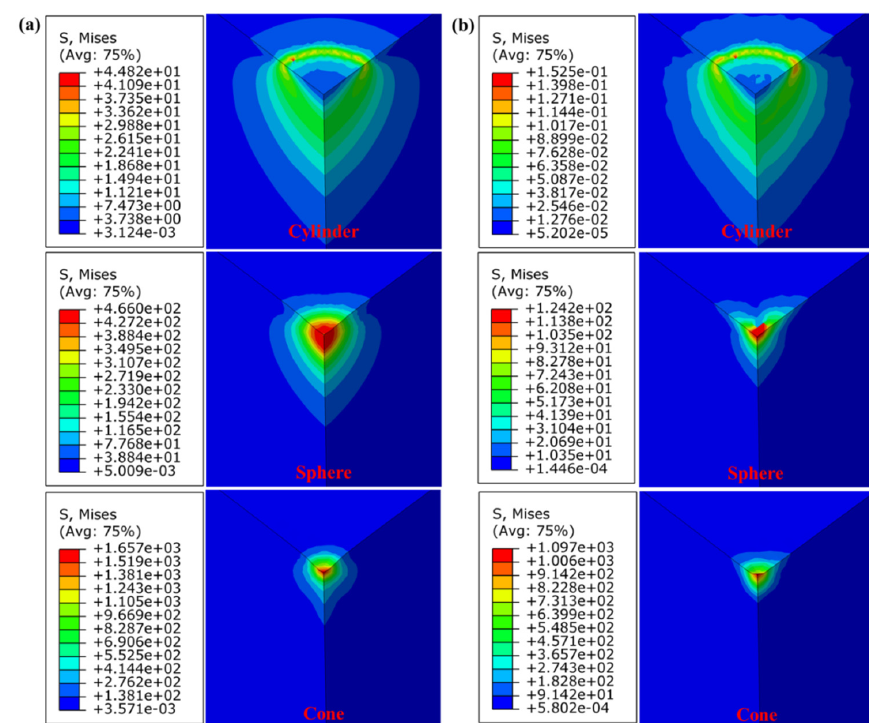
Figure 16. Comparison of the stress field for three types of indenters under static-dynamic loads: ( a ) Maximum Mises. ( b ) Minimum Mises. As there are large differences between the maximum and minimum stress for the three types of indenters, the uniform legend is not applicable here. Please note the color code for each experiment which present maximum and minimum stress for each